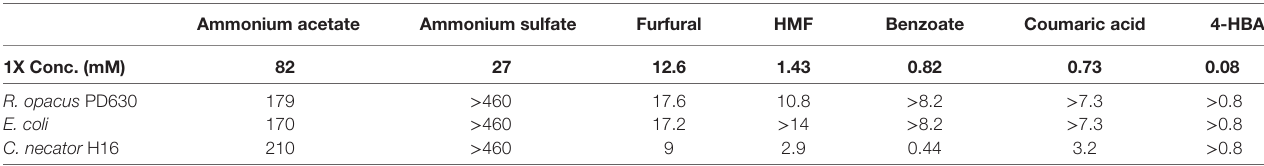
TaBle 4 | List of top bacterial growth inhibitors showing IC50 values of each chemical for three bacterial strains.